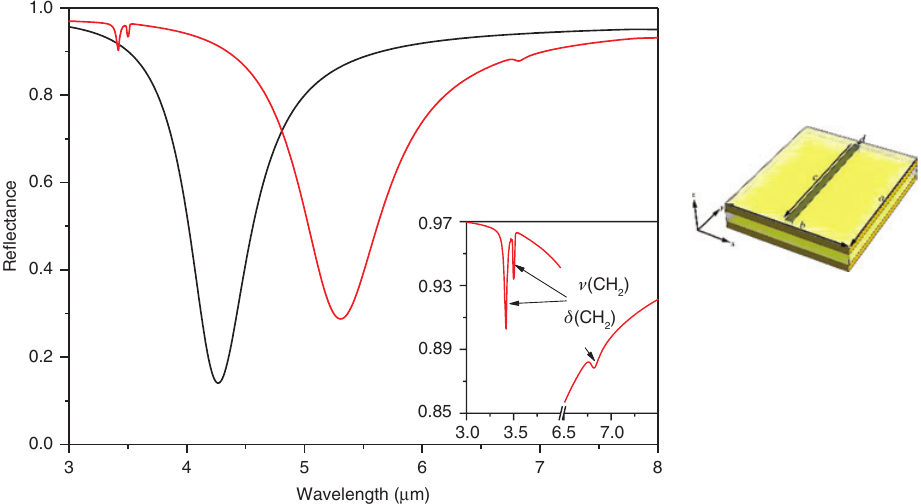
Figure 20: Simulated reflectance spectra of a slit perfect absorber for normal incidence. Compared are the x -polarized spectra of the slit PA with empty slit (black) and slit filled with PE (red). The inset gives an enlargement of the regions with PE